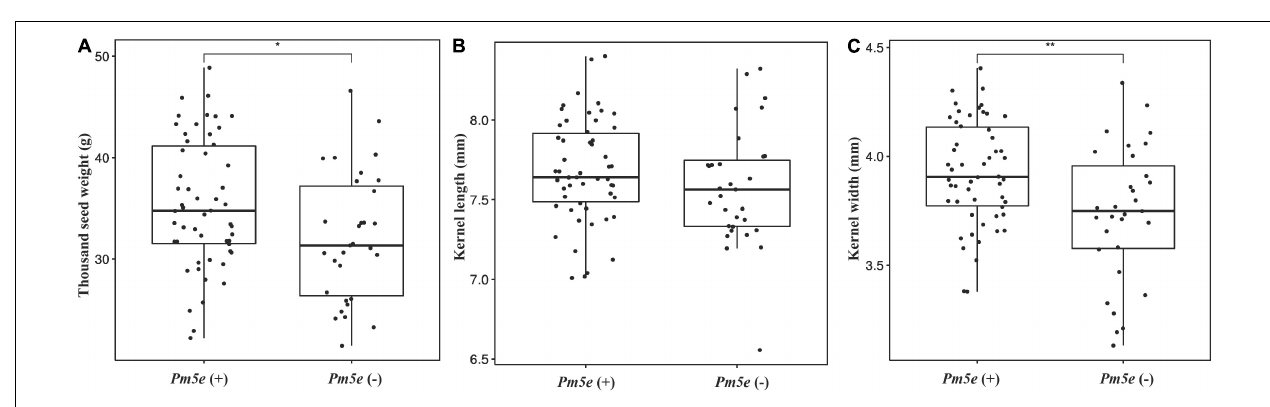
FIGURE 7 | Box plots of thousand-kernel weight (A) , kernel length (B) , and kernel width (C) for the lines with or without Pm5e from the cross H962R ×